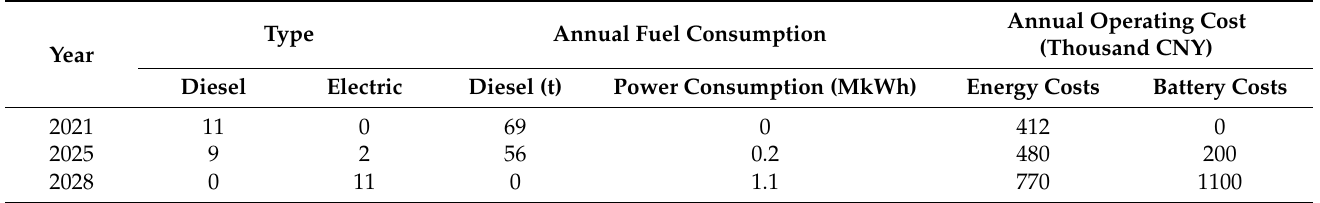
Table 3. Passenger ferry electrification energy cost